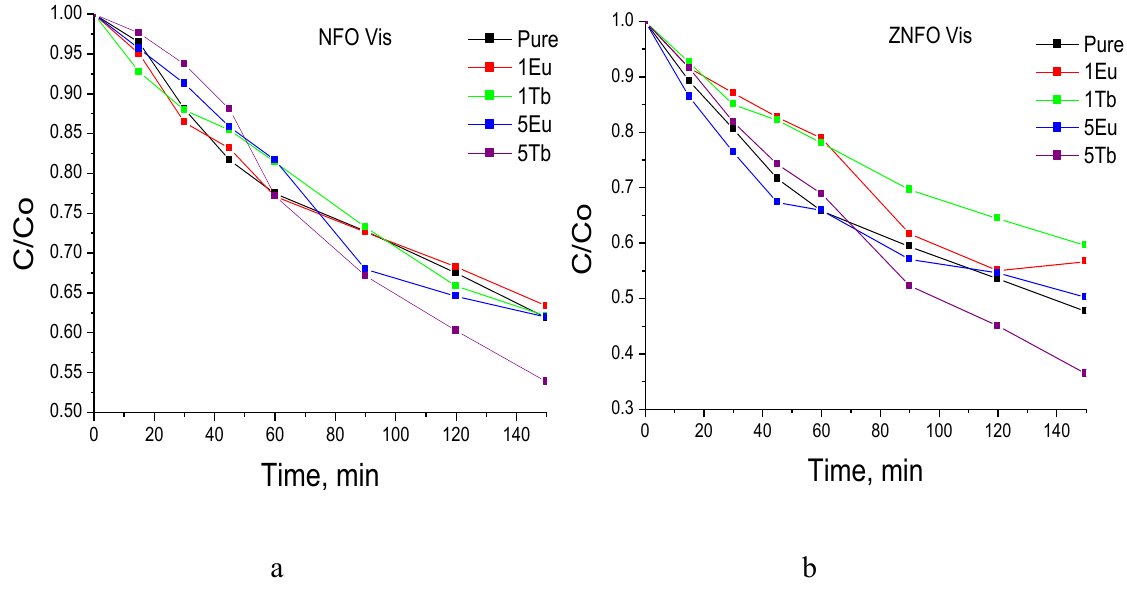
Figure 5: Degradation curves (C/C 0 dependence on the irradiation time) under visible light irradiation for pure and doped NF (a) and ZNF samples (b).